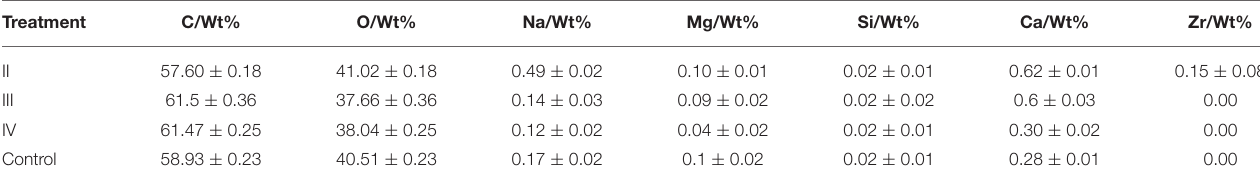
TABLE 3 | Content of mineral elements in pericarp treated with calcium in different periods.